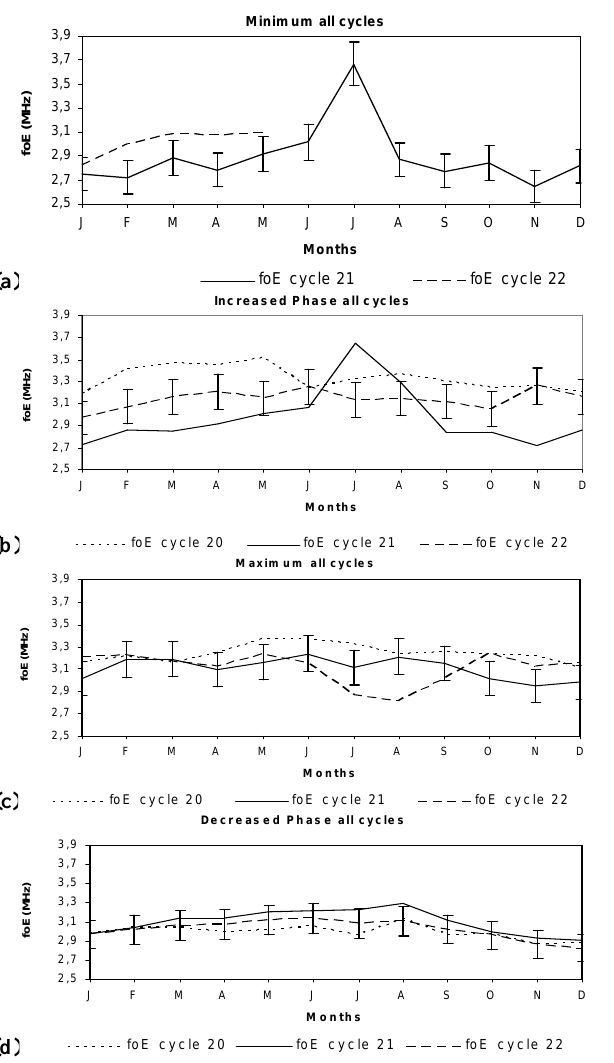
Fig. 4. Similar to Fig. 3 for fo E.